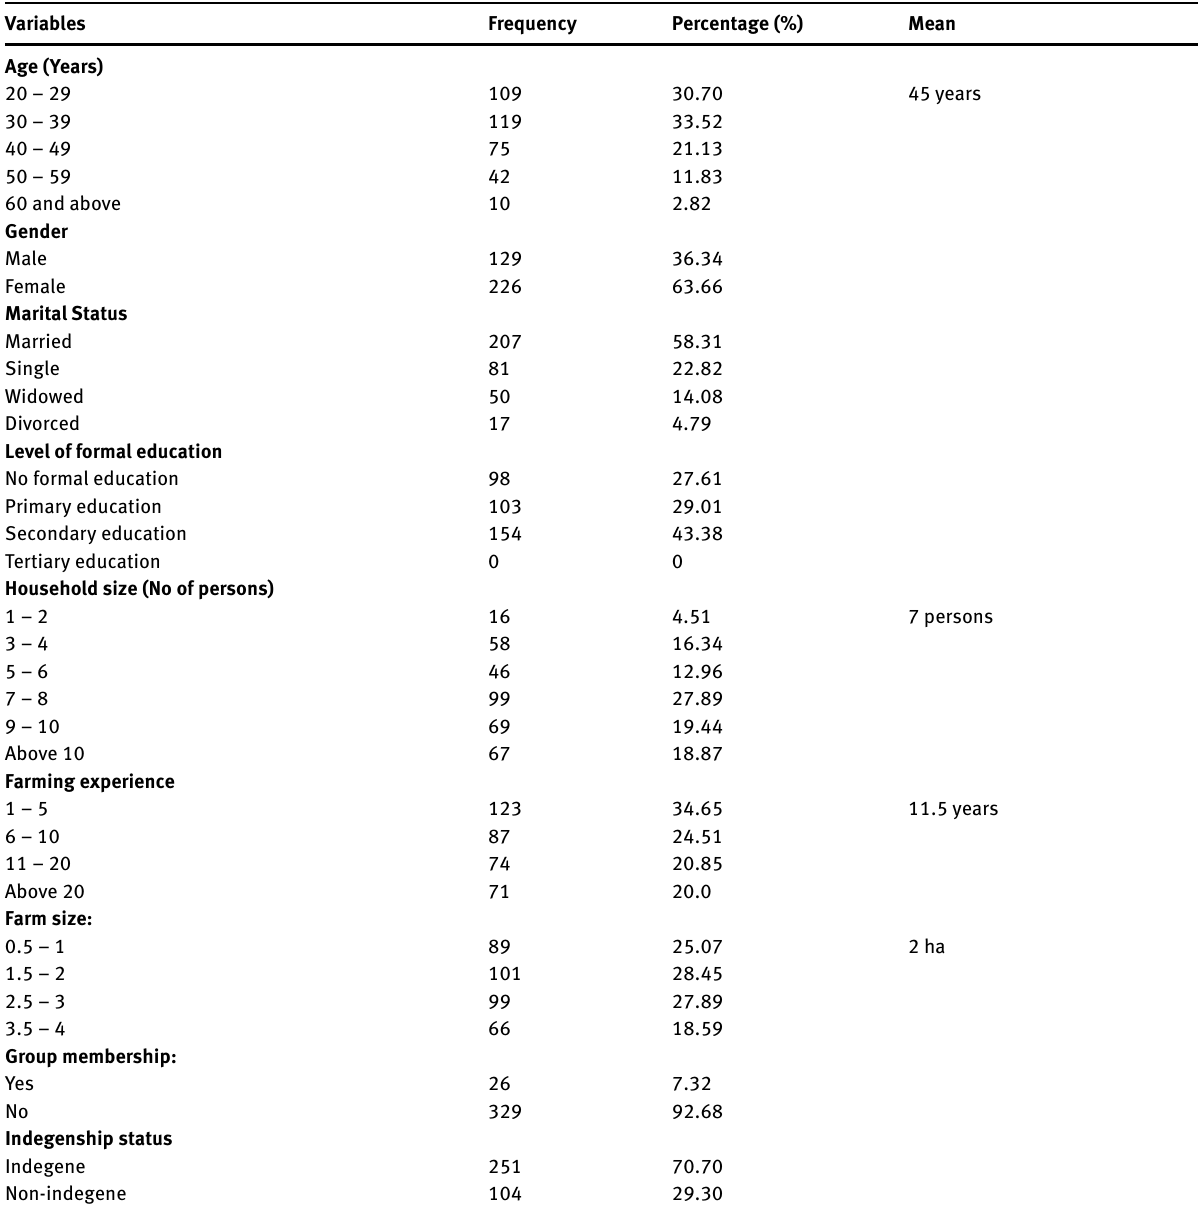
Table 1: S ocioeconomic characteristics of respondents